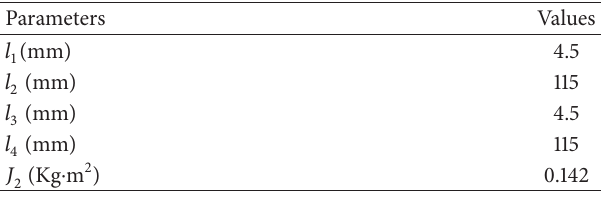
Table 1: Parameters of the equivalent parallel four-bar mechanism.